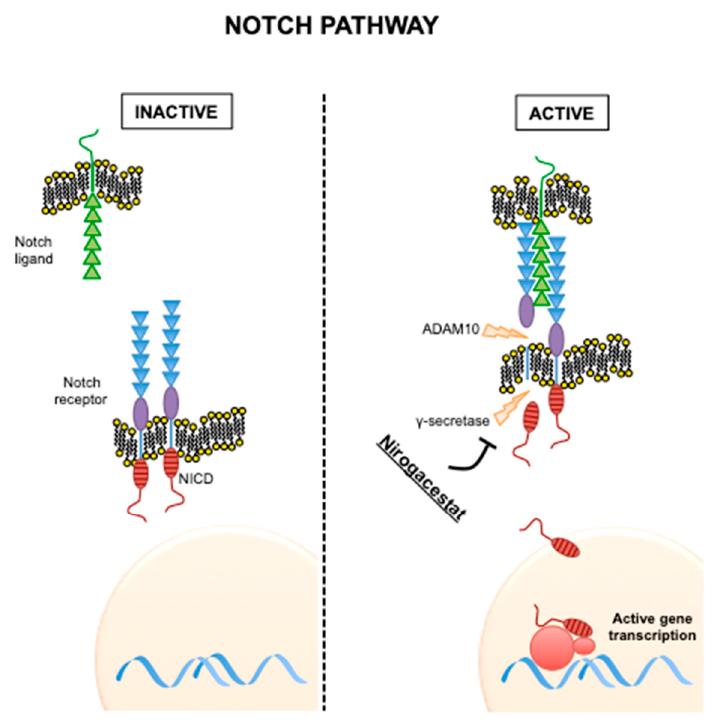
Figure 2. Notch pathway in its inactive and active states. Mechanism of action of nirogacestat is shown.